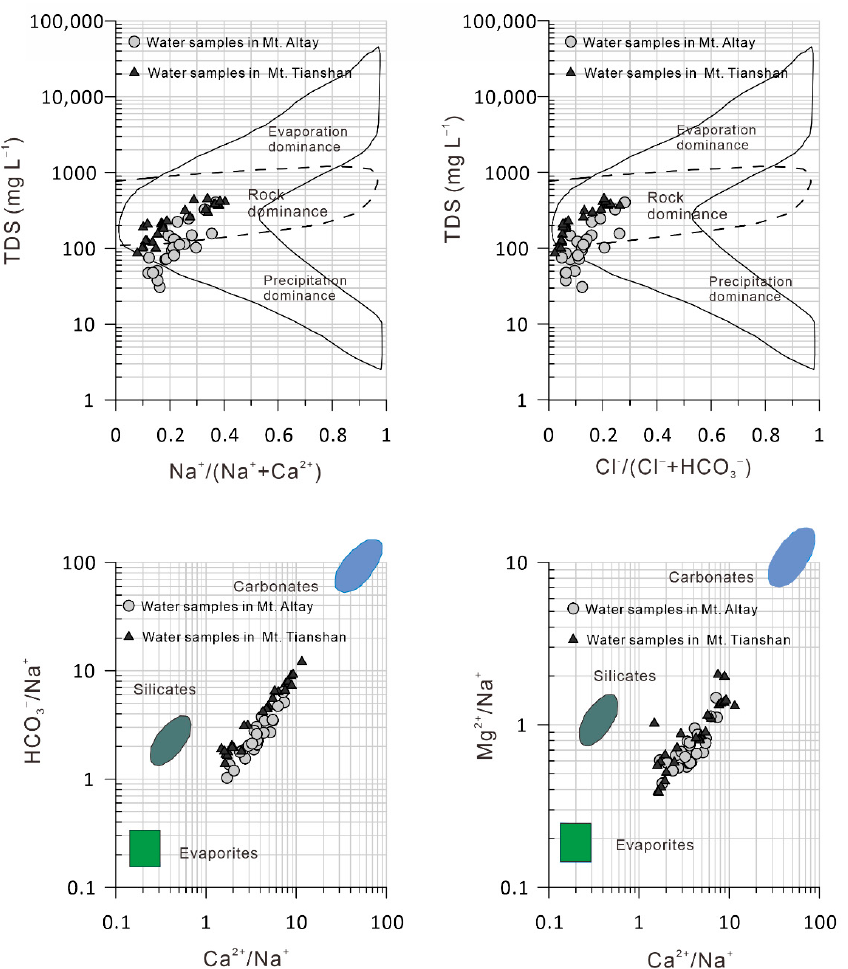
Figure 8. The Gibbs and mixing diagrams for the waters in the regions of the Tianshan and Altay Mts.